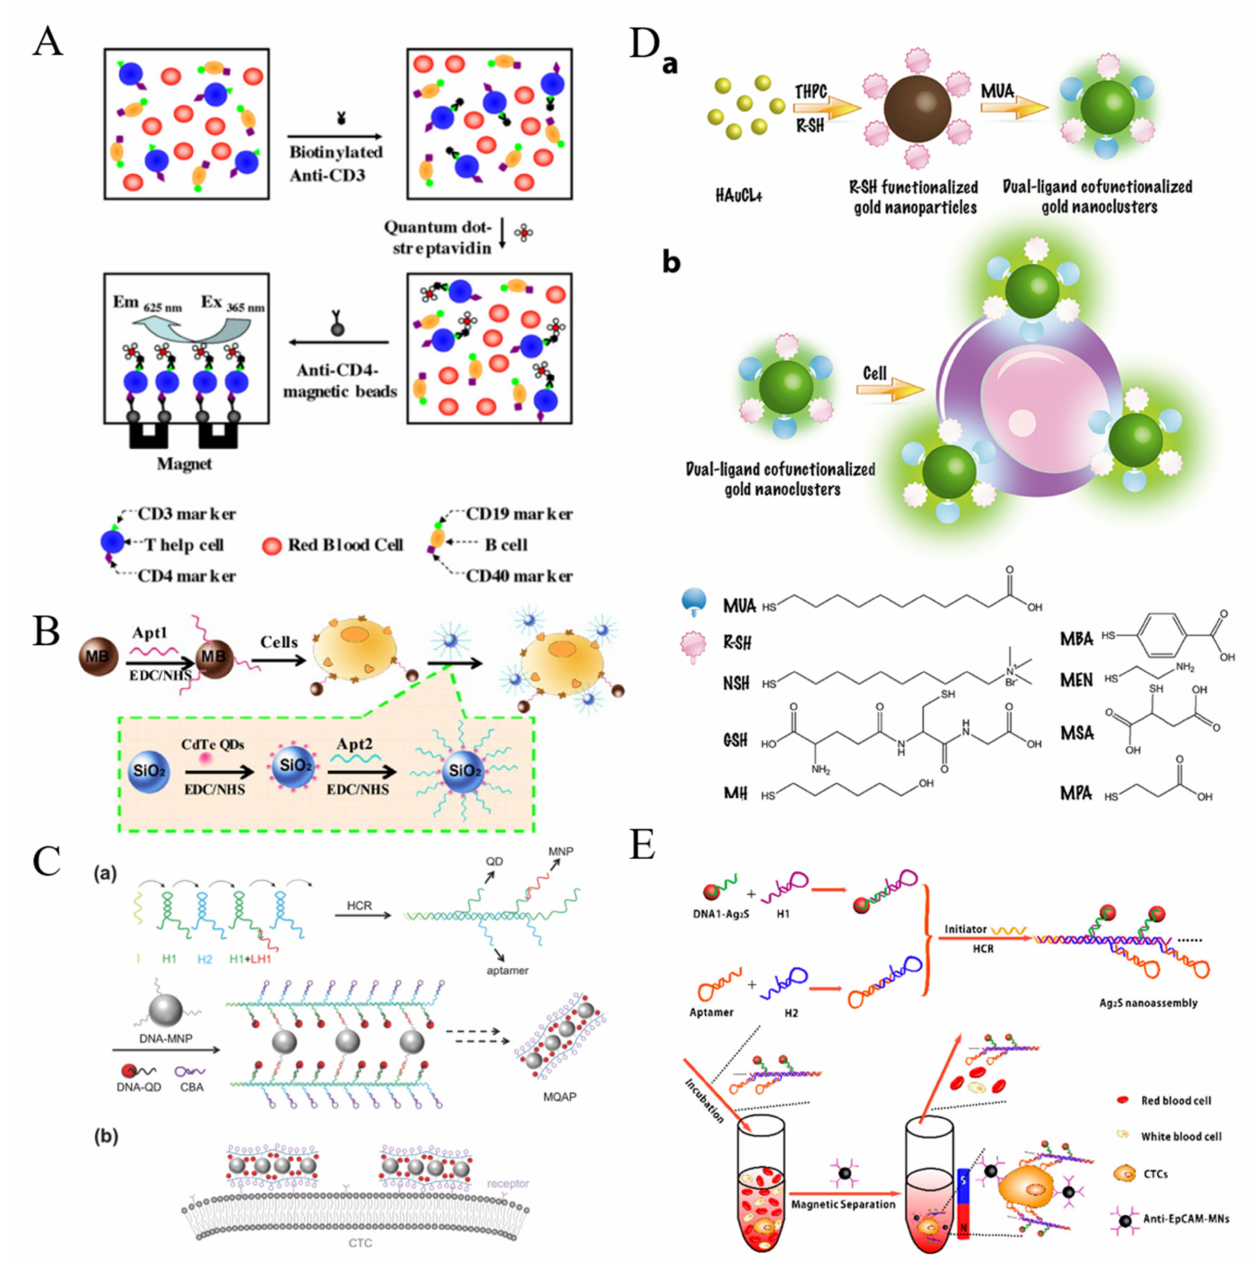
Figure 2. ( A ) Illustration of detecting the specific T-help cells using combination of two biomarkers with quantum dots as fluorescence probe and magnetic beads for immuno-separation [75]. Copyright 2011 Elsevier B.V. ( B ) Illustration of isolation and detection of MCF-7 cells by employing MUC1 aptamer-functionalized MBs and AS1411 modified QDs loaded on the surface of SiNPs [76]. Copyright 2013 Elsevier B.V. ( C ) Schematic illustration of MQAPs for magnetic isolation of CTCs. (a) Construction of MQAPs in two steps: (i) hybridization chain reaction mediated formation of the polymeric DNA template and (ii) co-assembly of DNA-QDs, DNA-MNPs, and DNA aptamers with the DNA template. (b) Multivalent binding between MQAPs and cell surface receptors for CTC isolation and detection [80]. Copyright 2018 WILEY-VCH. ( D ) Schematic illustration of the synthesis of the dual-ligand co-functionalized AuNCs and preparation of sensor array for cell identification based on the dual-ligand co-functionalized AuNCs. (a) Schematic illustration of the synthesis of the dual-ligand cofunctionalized gold nanoclusters. (b) Preparation of sensor array for cell identification based on dual-ligand cofunctionalized gold nanoclusters [81]. Copyright 2017 Elsevier B.V. ( E ) Schematic illustration of the procedure of isolation and detection of CTCs through the combination of Ag 2 S nanoassembly and anti-EpCAM-MNs [82]. Copyright 2018 American Chemical